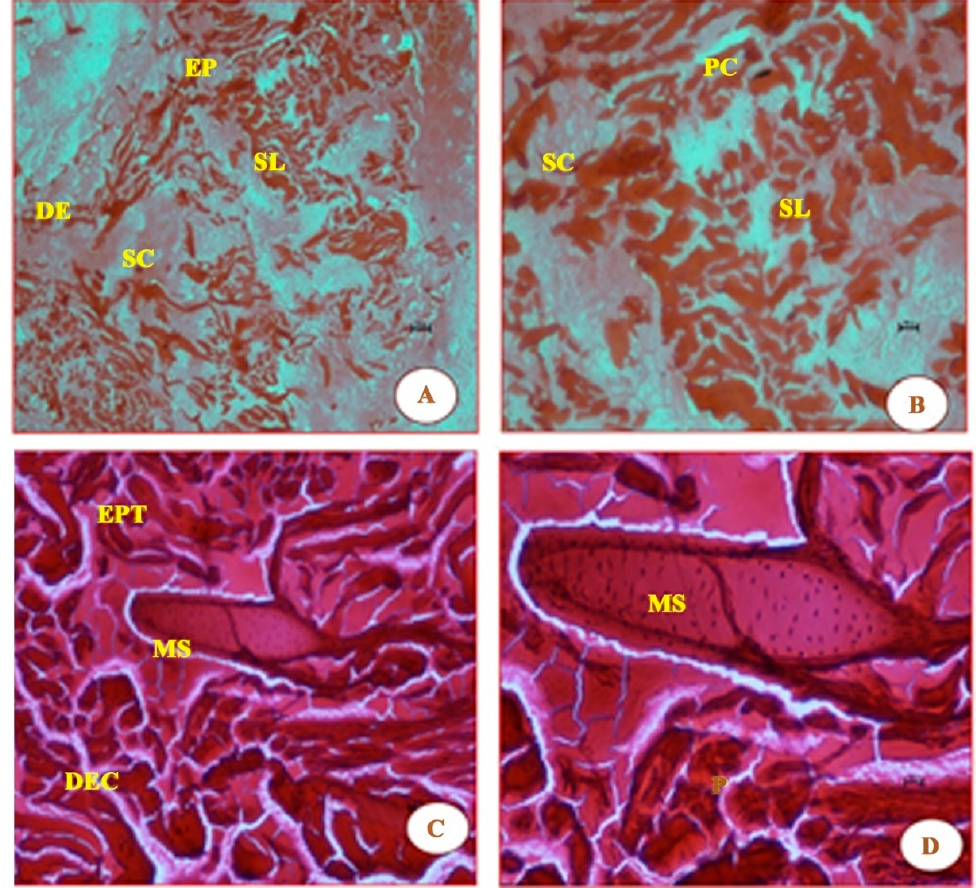
Figure 3. Essentially, the same features as Figure 2 are shown, which are as follows: epidermis (EP), stratum laxum (SL), stratum compactum (SC), epithelial tissue (EPT), dermis (DE), dense epidermal cells (DEC); they were also all stained with haematoxylin and eosin. The micrographs noted in these panels are due to the effect of UVA ( λ = 320 nm) radiation. Panels ( A , B ) in Figure 3 show the difference in damage to the various tissues when compared to those in Figure 2, i.e., the tissues in Figure 2 panels A and B are smooth and undamaged. The additional new features observed in panels ( C , D ) are mucus cells (MS)—the MS featured in the latter two panels became visible due to samples being magnified at 20X and 40X, respectively. Panels ( C , D ), in particular, also show cells to be enlarged and rough, compared with those in Figure 2, which are small and smooth.